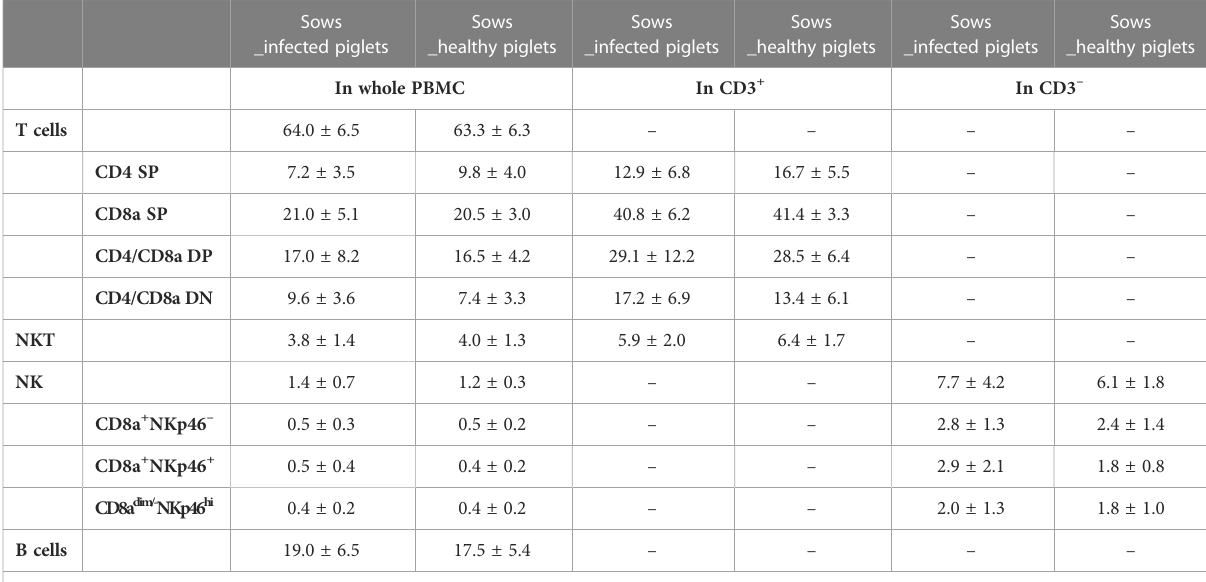
Table 1 Percentage of T cell subsets, NKT, NK cells, and B